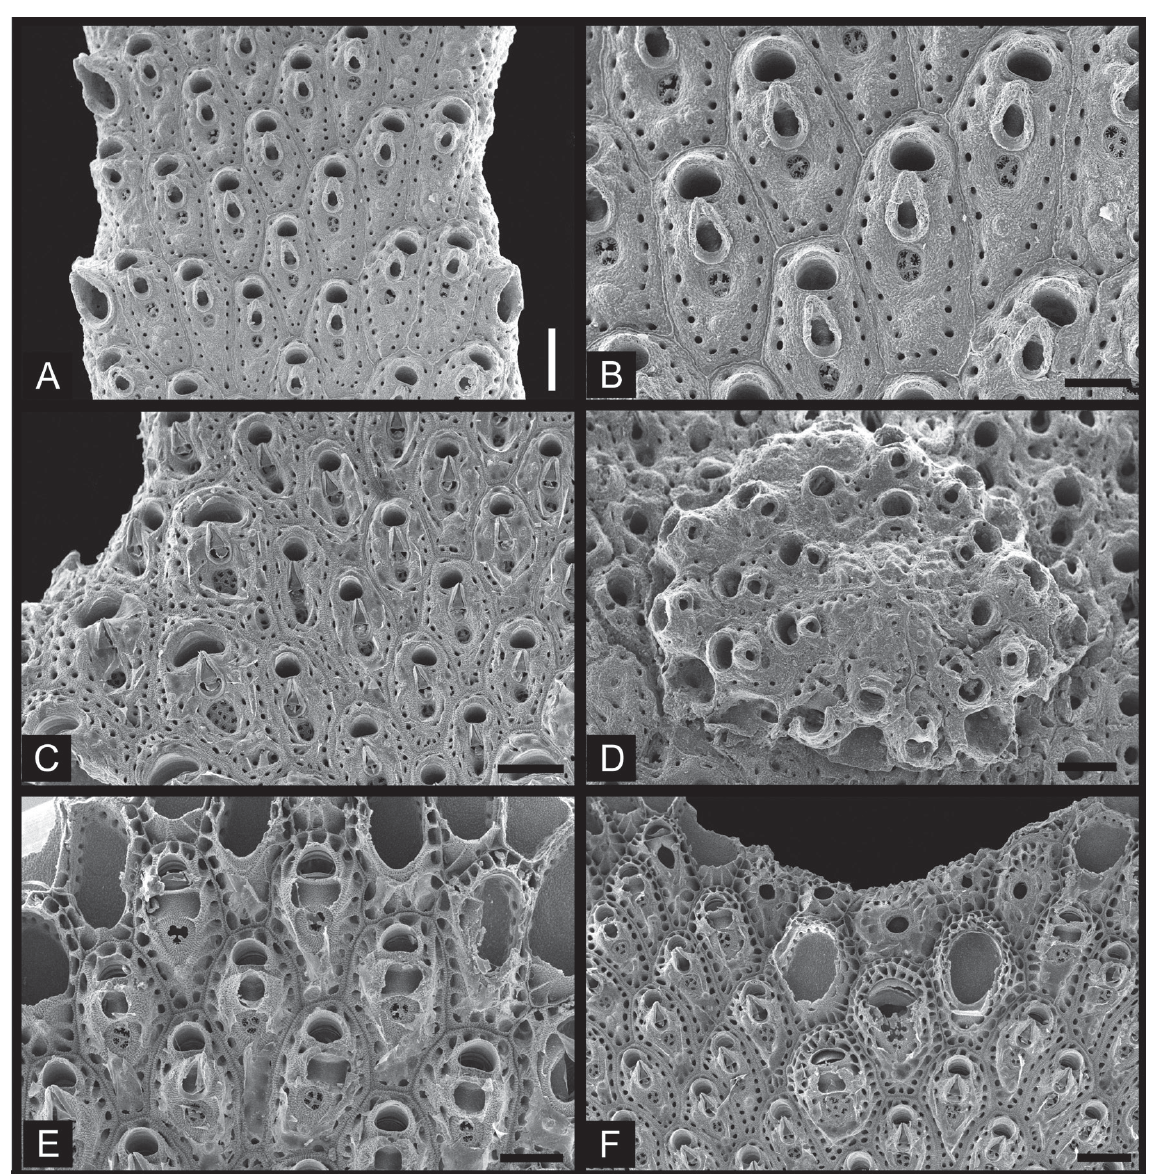
Fig. 13. Adeonellopsis sparassis (ortmann, 1890) . A . Autozooids and marginal vicarious avicularia (NsMT-Te772). B . enlargement of autozooids (NsMT-Te772). C . Autozooids and gonozooids (NsMT- Te774). D . Young, encrusting colony (NsMT-Te770). E . Young autozooids, showing circular spiramen and large areolar pores (NsMT-Te774). F . Young autozooids and gonozooids at branch bifurcation (NSMT-Te774). SEM images. Scale bars: A, C = 300 μm; B = 150 μm; D–E = 200 μm; F = 300